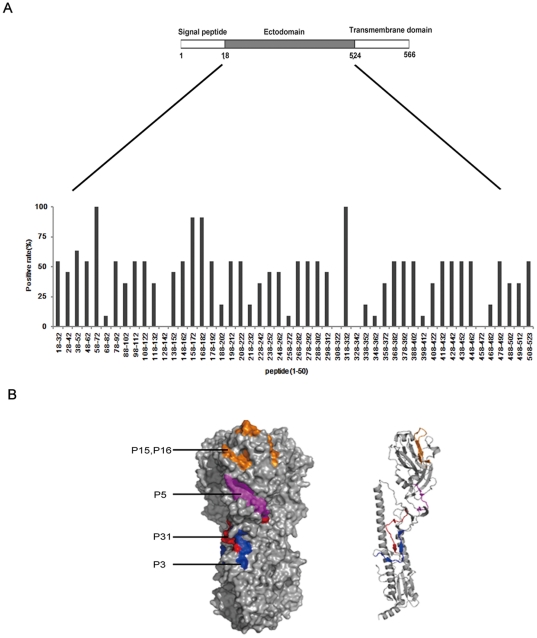
Identification of immunodominant epitopes in the HA protein of H1N1pdm influenza virus by peptide scanning analysis.(A) A set of 50 peptides that cover the ectodomain of the HA protein of A/California/04/2009 strain were used to coat 96-well microplate. Sera (1∶200 dilution) from 11 H1N1pdm patients and 10 healthy donors were screened for the presence of antibodies to the 50 peptides using ELISA. The positive rate of H1N1pdm sera for each peptide was calculated and plotted. (B) The identified peptides displayed in stereo view. The HA trimer surface view of H1N1pdm influenza virus (PDB ID:3LZG) is shown on the left and colored to illustrate the five immunodominant peptides. From most membrane distal to proximal: P15 and P16 (orange, residues 158–182), P5 (magenta, residues 58–73), P31 (red, residues 318–332), P3 (blue, residues 38–52). The HA monomer cartoon view is shown on the right and the same coloring scheme applies to the structure on the left.